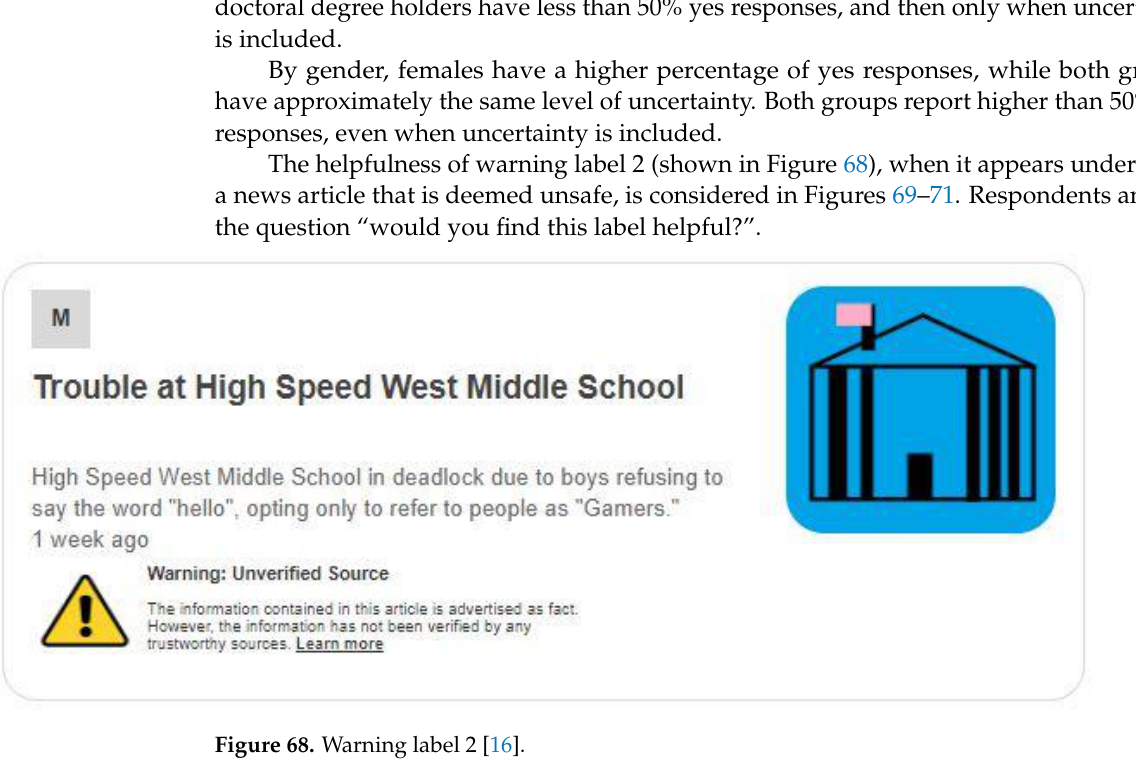
Figure 67. Label trustworthiness judging use, by gender: ( a ) with uncertain respondents (left) and ( b ) without uncertain respondents (right).